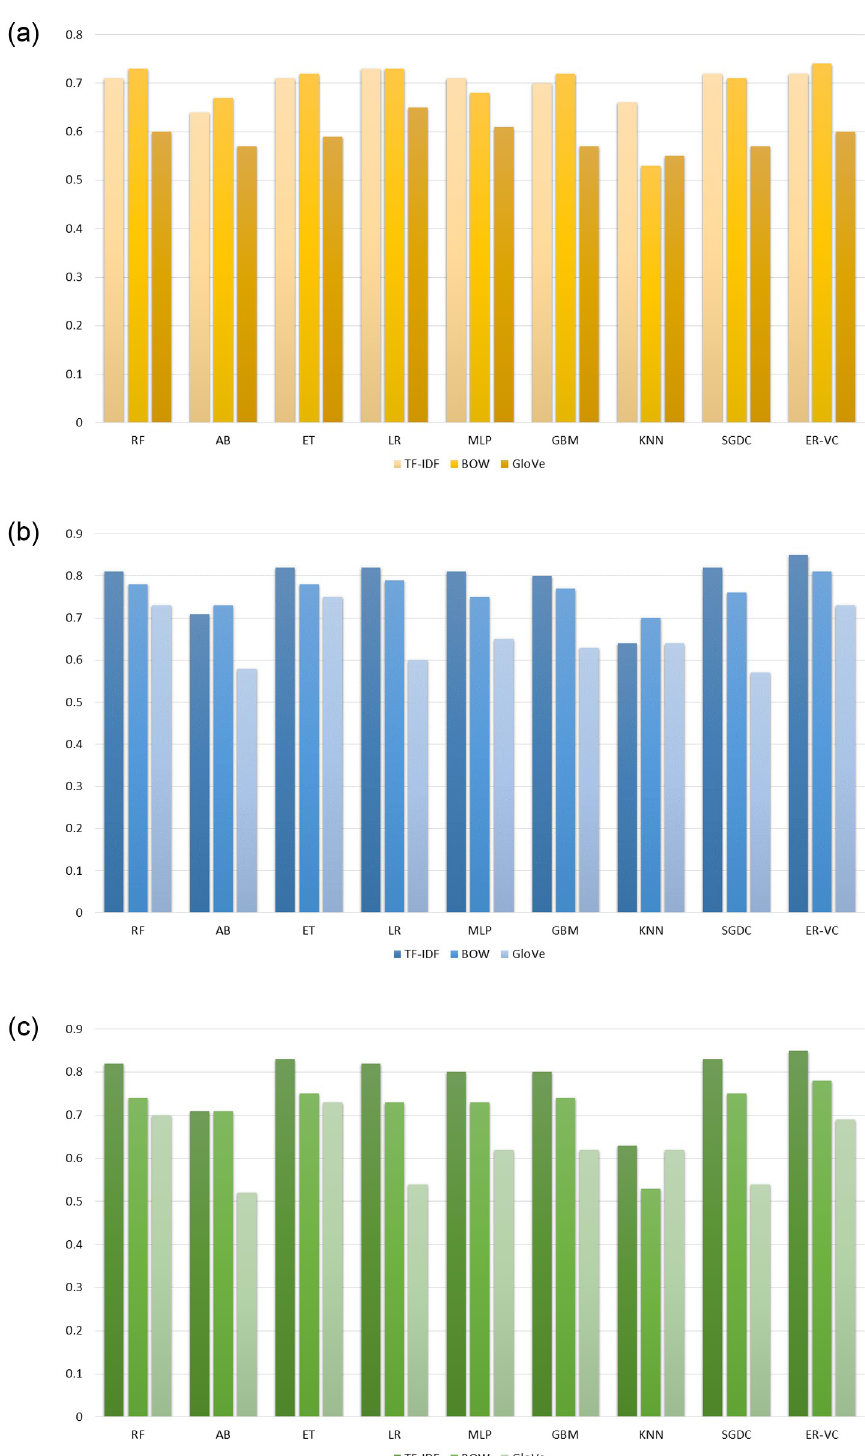
Fig 5. Performance analysis of ML models, (a) accuracy using TF-IDF, BoW and GloVe without SMOTE, (b) accuracy using TF-IDF, BoW and GloVe using SMOTE, and (c) accuracy using TF-IDF, BoW and GloVe using